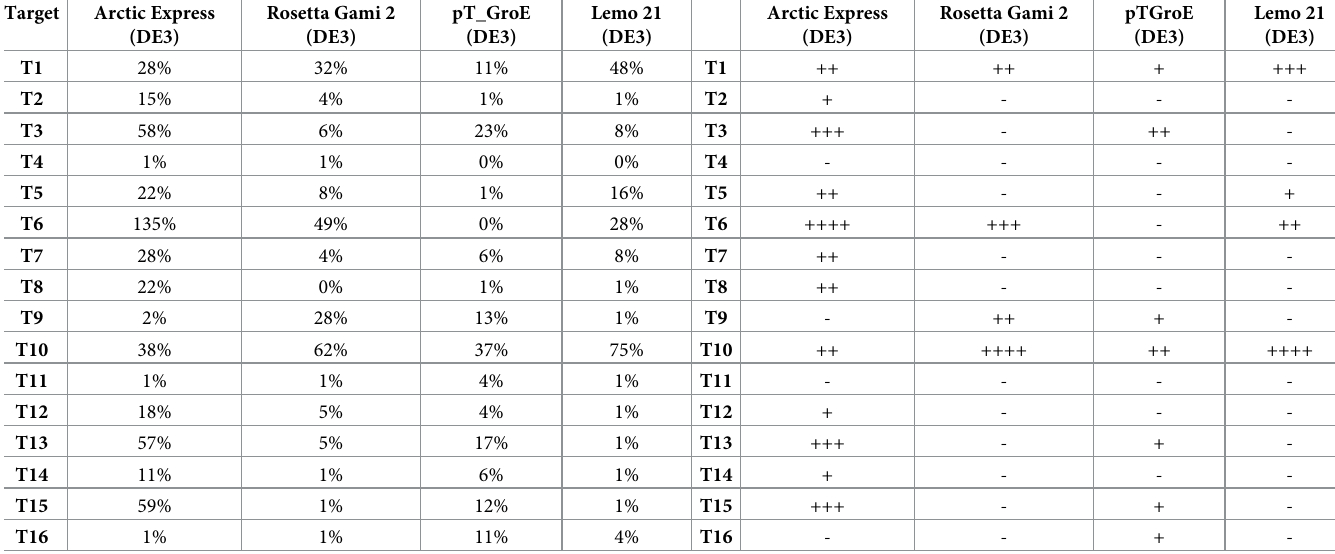
Table 2. Summary of the soluble protein recovery using different E . coli strains culture medium. ( left ) The expression levels were quantified using the software ImageJ and normalized by the intensity of the band from the molecular marker at 30kDa, as shown in Fig 2. ( right ) The normalized intensities shown in the left are reported in the scale no expression (-, intensity I < 10%), small yield ( + , 10% < I < 20%), reasonable yield (++ , 0.2 < I < 0.4), good yield (+++ , 0.4 < I < 0.6) and excellent yield (I >